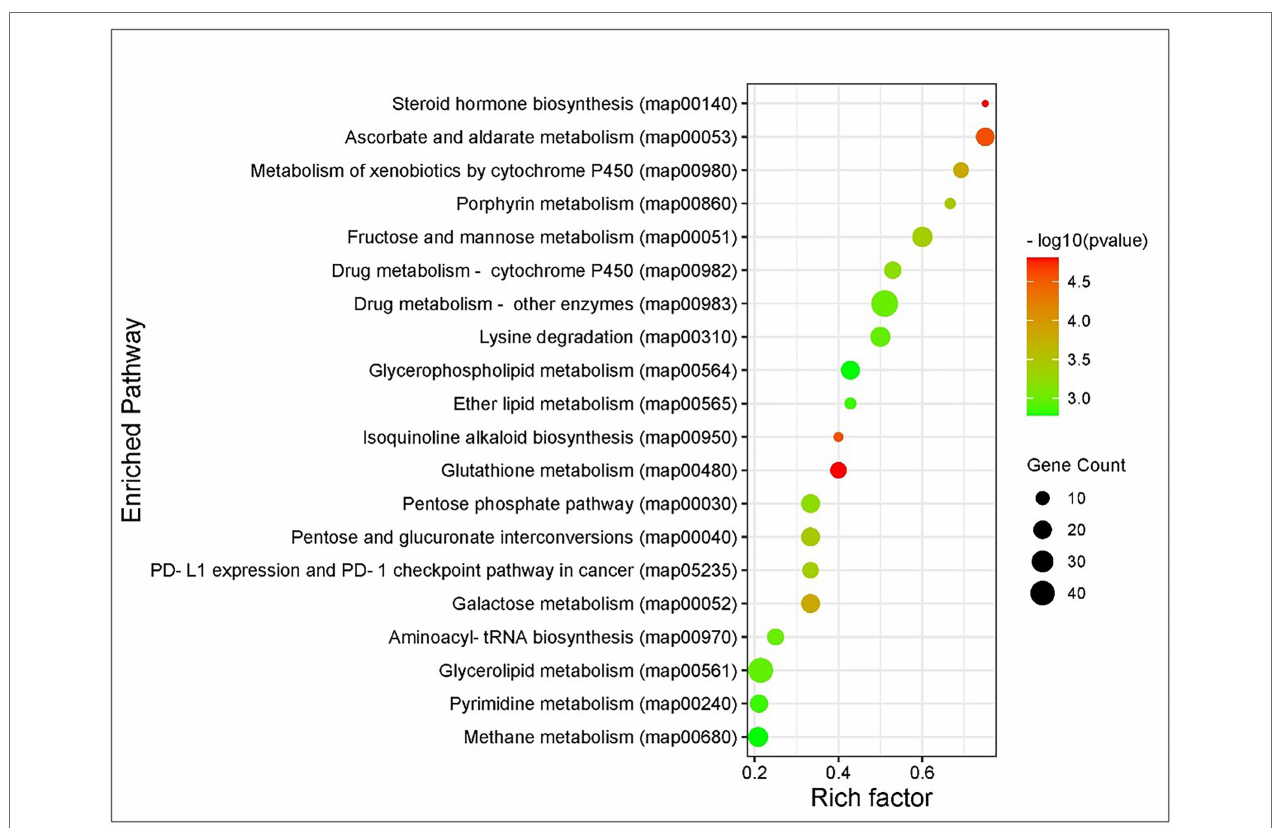
FIGURE 3 | Kyoto Encyclopedia of Genes and Genomes (KEGG) pathway enrichment analysis of DEGs of Thrips palmi in response to groundnut bud necrosis virus (GBNV) infection. The rich factor is defined as the ratio of the number of DEGs annotated in a pathway to the number of all genes annotated in this pathway. Y axis indicates the pathway name; x axis indicates the enriched factor in each of the pathways. The bubble size indicates the number of DEGs. The color bar indicates the corrected value of p , the red represents a higher value, and the green represents a lower